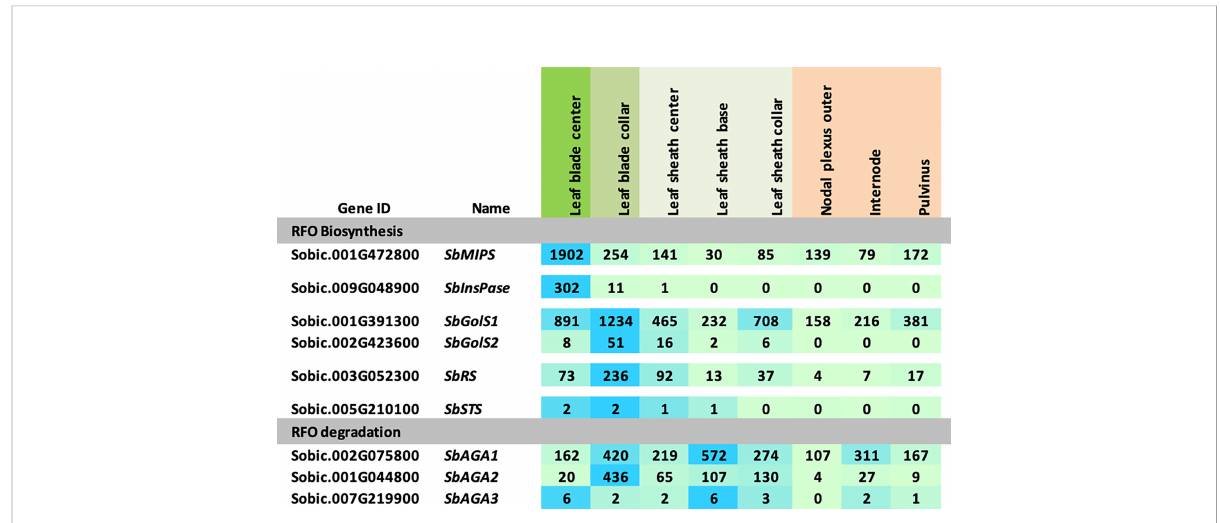
FIGURE 2 Expression of RFO metabolism genes in various tissues of the energy sorghum hybrid TX08001. Numeric data represents TPM normalized expression. Each data point is the mean of three biological replicates. In the heat map, the darker the blue the higher the